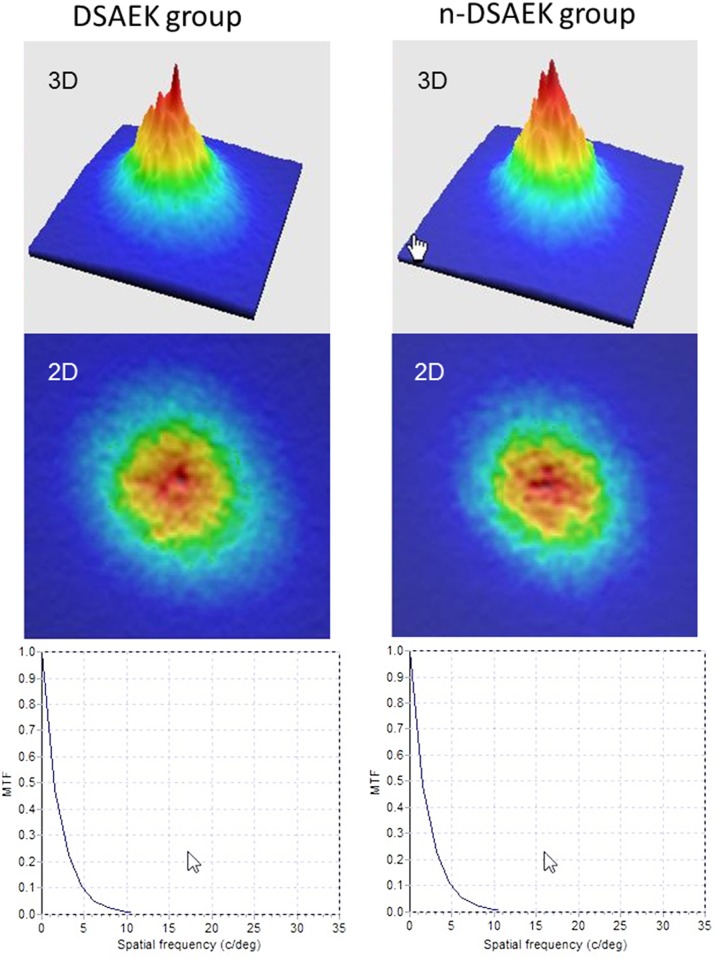
The double-pass images of eyes undergoing Descemet’s stripping automated endothelial keratoplasty (DSAEK) and non-Descemet’s stripping automated endothelial keratoplasty (n-DSAEK).MTF = modulation transfer function.